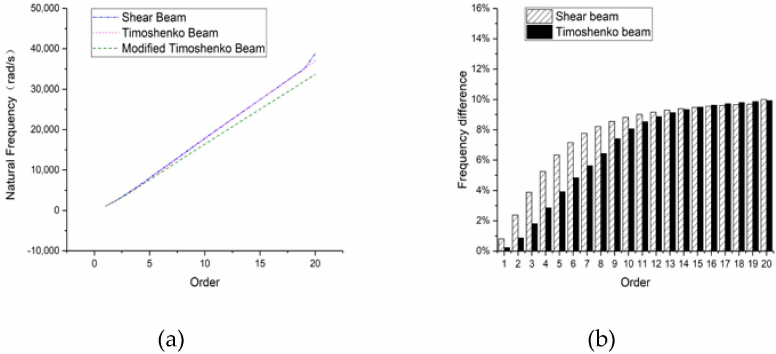
Figure 17. Frequencies of the 4-m-long beam: ( a ) overall frequency curve and ( b ) frequency di ff erence compared with a modified Timoshenko beam.